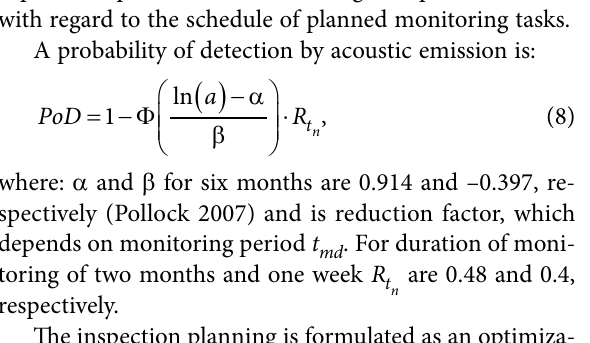
Figure 2. Schematic representation of the analysed structure